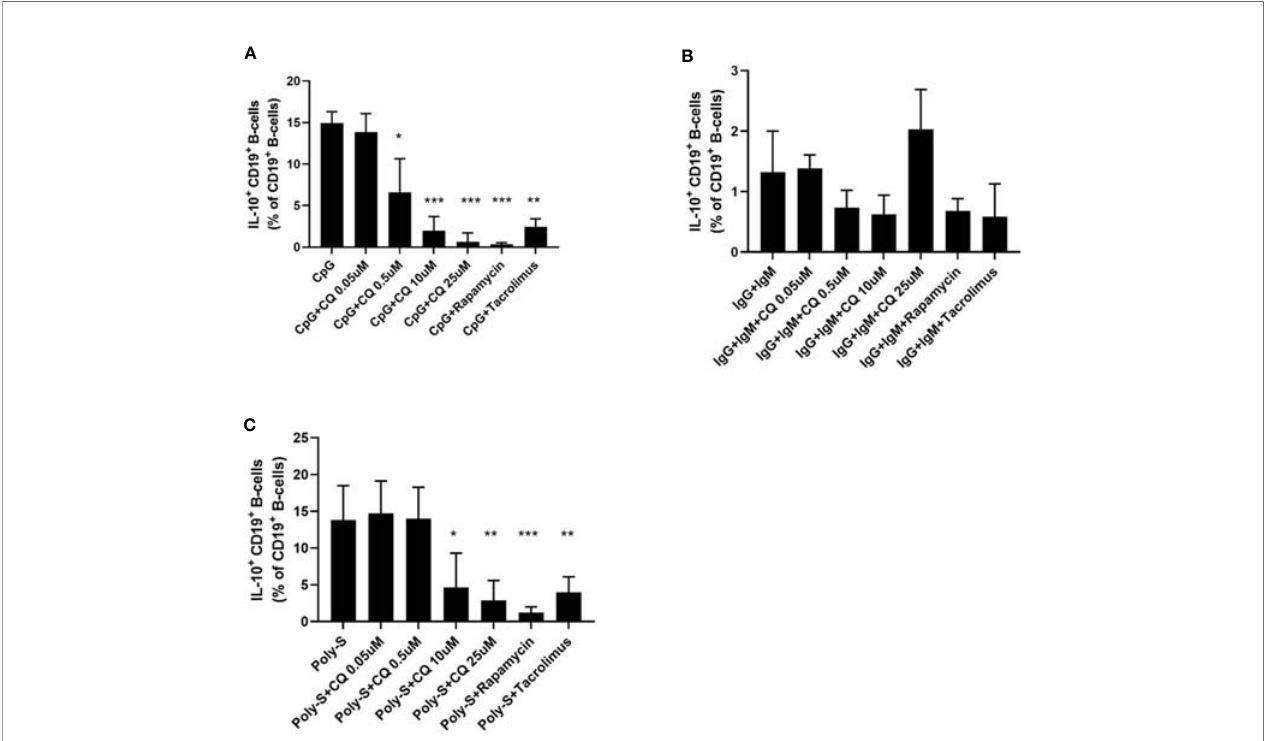
FIGURE 3 | Effect of CQ on IL-10 pos regulatory B-cells. PBMCs were cultured in presence of different stimuli and CQ at four concentrations (0.05 µM, 0.5 µM, 10 µM, 25 µM) for 72 hours. Rapamycin and tacrolimus were also used as controls. After 72 hours, the production of IL-10 by CD19 + B-cells was determined by fl ow cytometry. (A) Impact of CQ on IL-10 + CD19 + B-cells upon CpG stimulation in PBMC. (B) Impact of CQ on IL-10 + CD19 + B-cells upon IgG+IgM stimulation in PBMCs. (C) Impact of CQ on IL-10 + CD19 + B-cells upon Poly-S stimulation in PBMCs. P-values were calculated by repeated-measures ANOVA and correction for multiple comparisons were done by Dunnett ’ s test. *p < 0.05, **p < 0.001, ***p < 0.0001 (against CpG, IgG+IgM or Poly-S as control conditions).